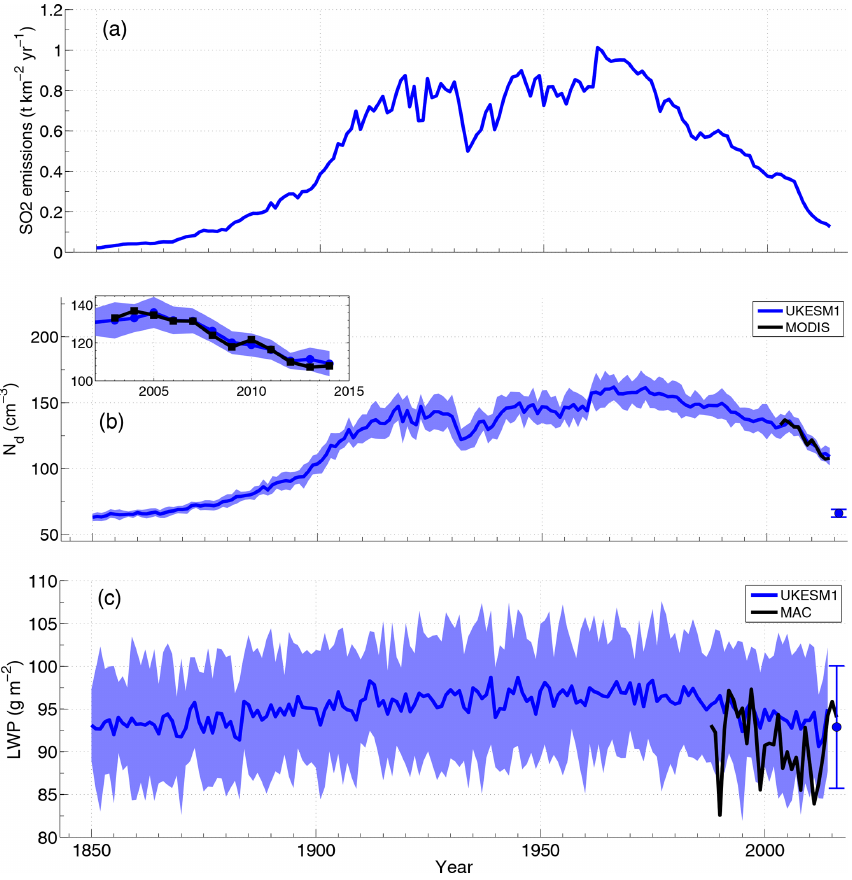
Figure 7. Time series of the annual mean CMIP6 emission rate for anthropogenic SO 2 (a) for the continental US region (26–50 ◦ N, 70– 100 ◦ W; land-only grid points), the cloud droplet number concentration ( N d , b ), and the all-sky (i.e., including both cloudy and clear parts of grid boxes) liquid water path (LWP, c ) for a region in the Atlantic Ocean downwind of the US (26–42 ◦ N, 56–80 ◦ W; ocean-only grid points). Lines are shown for the UKESM1 model ensemble mean, the MODIS satellite instrument using the collection 5.1 product, and the MAC microwave satellite LWP dataset. The blue shading denotes ± 2 times the intermodel standard deviation across the ensemble. The error bar plotted at the year 2016 for the N d and LWP plots shows the ± 2 σ range of the annual average values from the pre-industrial control run along with the time mean (blue dot). The inset figure in the N d plot shows a closeup of the time period for which observations are available using the same